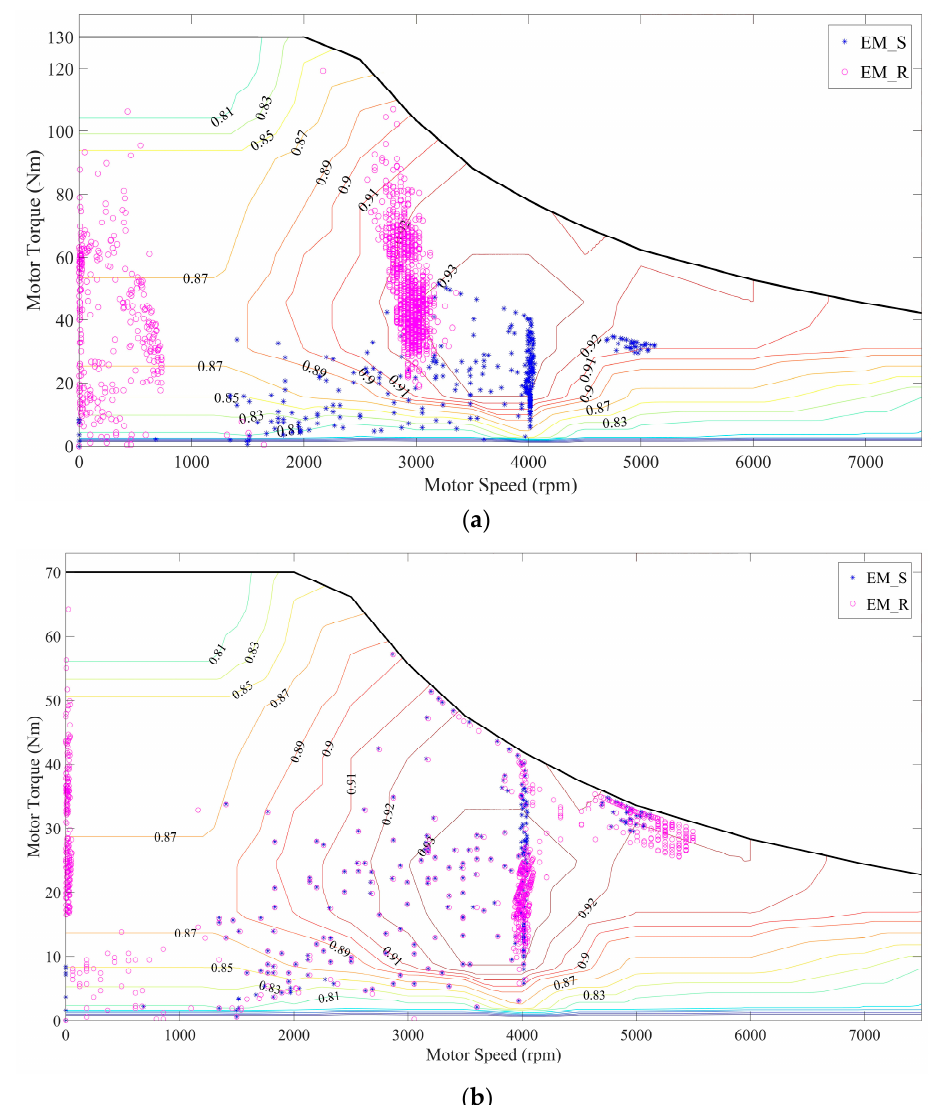
Figure 11. ( a ) Working points of EM_S at PDR = 0.65 and EM_R at PDR = 0.35; ( b ) working points of EM_S at PDR = 0.35 and EM_R at PDR = 0.65.